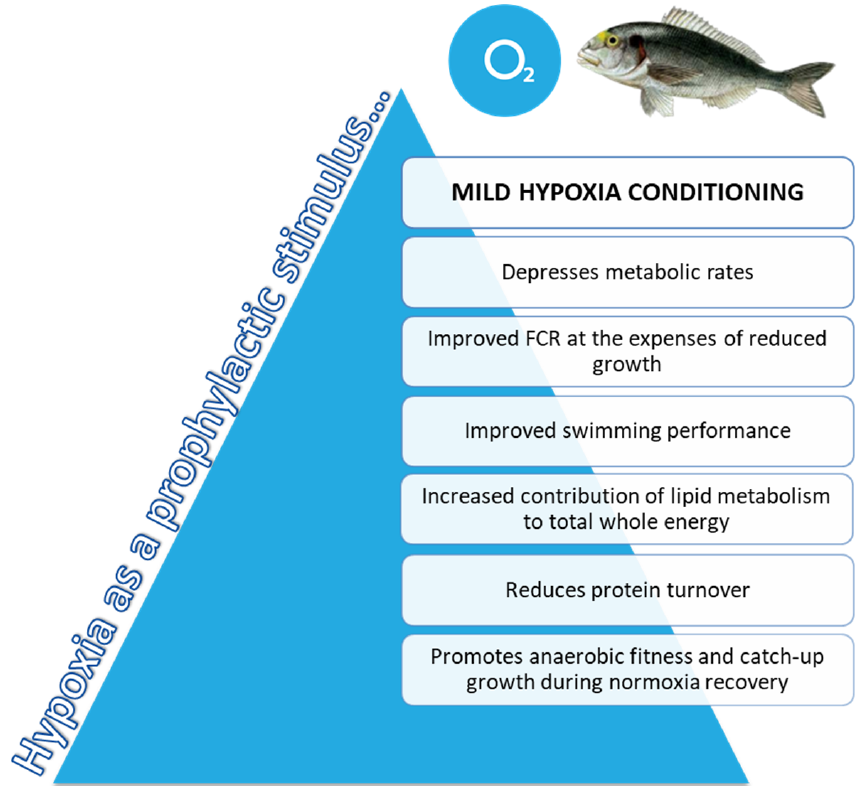
Figure 7. Schematic representation of the proposed model for integrative responses of gilthead sea bream exposed to mild-hypoxia stress conditioning.